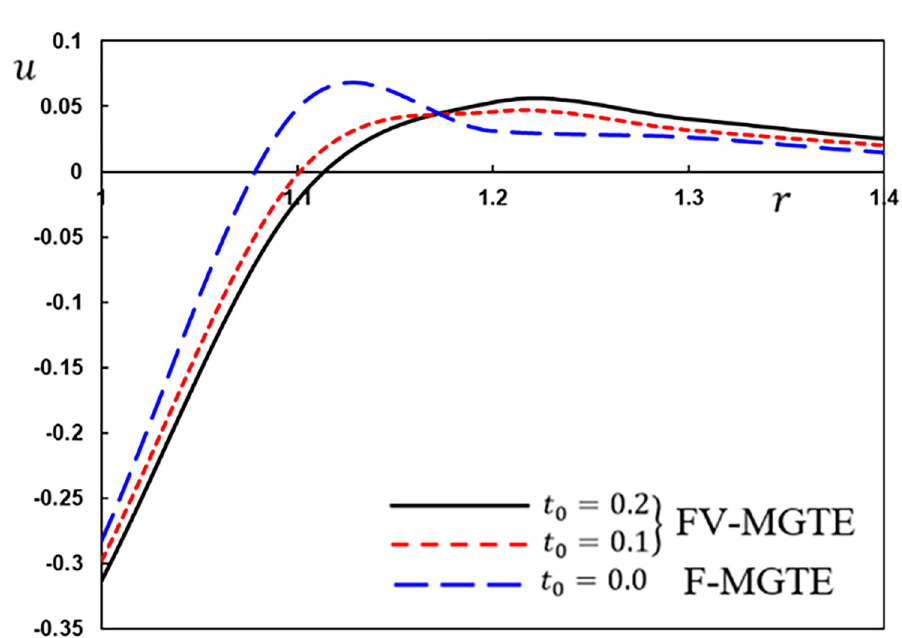
Fig 14. The displacement variation u for different viscosity parameter η .